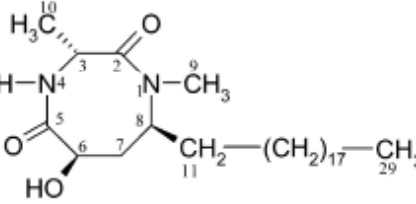
Figure 13. 6-Hydroxy-1,3-dimethyl-8-nonadecyl-[1,4]-diazocane-2,5-diketone [107].